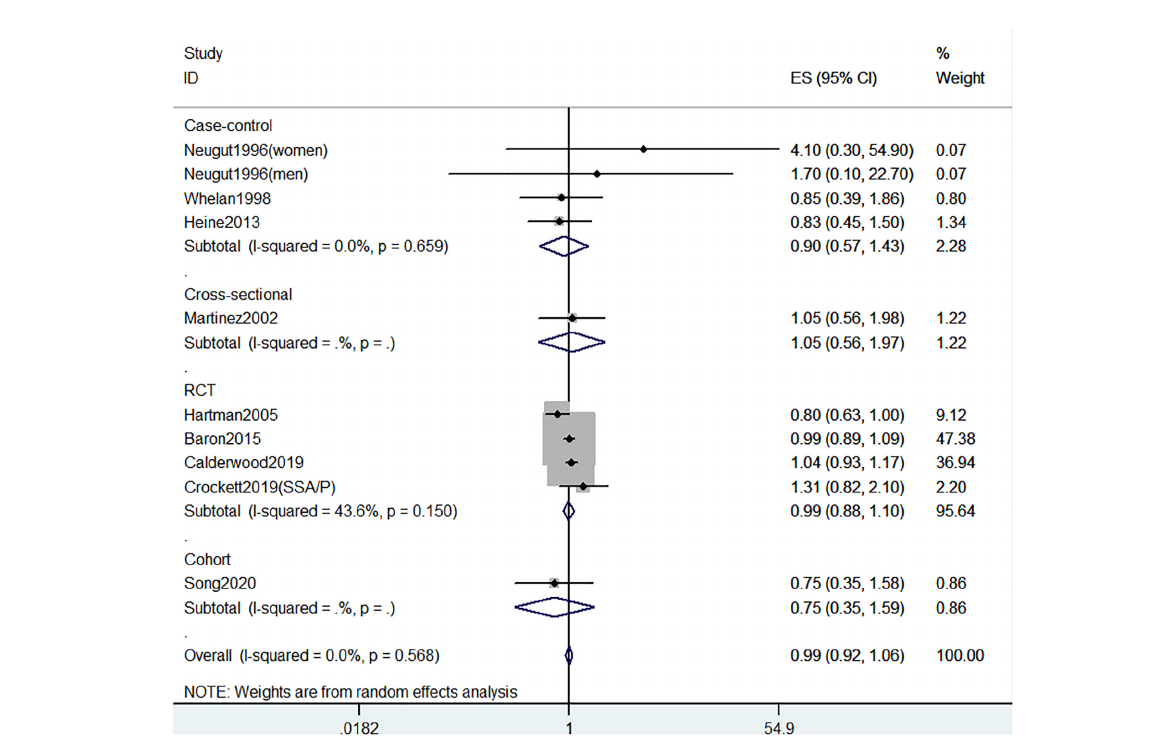
FIGURE7 Random-effects meta-analysis of studies that examined supplementary vitamin D intake and risk of CRC precursors recurrence. ES, effect size.